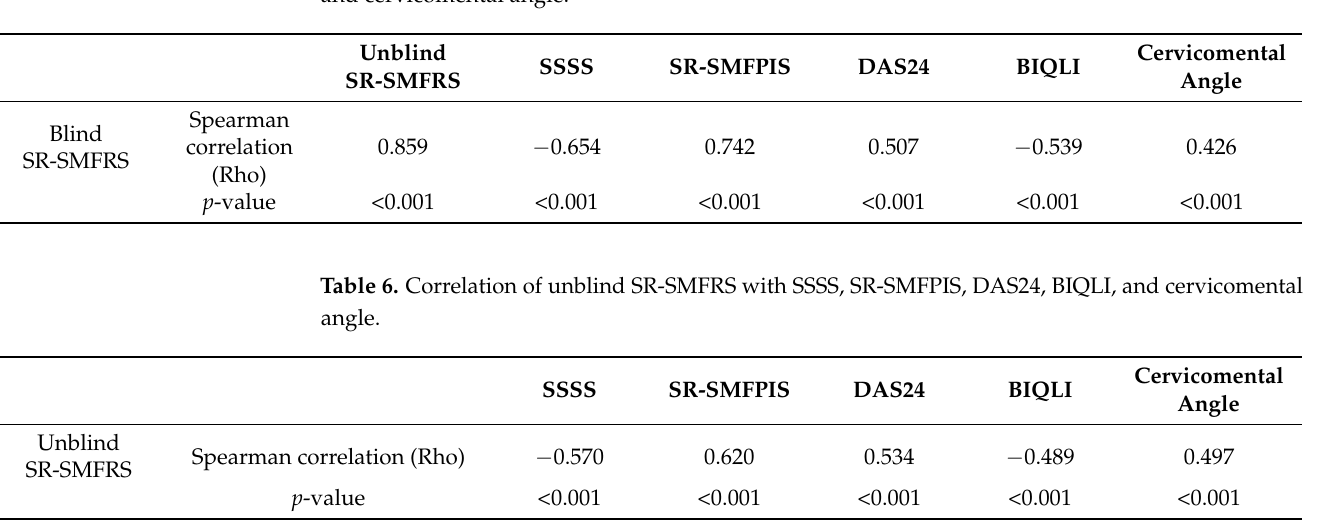
Table 5. Correlation of blind SR-SMFRS with unblind SR-SMFRS, SSSS, SR-SMFPIS, DAS24, BIQLI, and cervicomental angle.